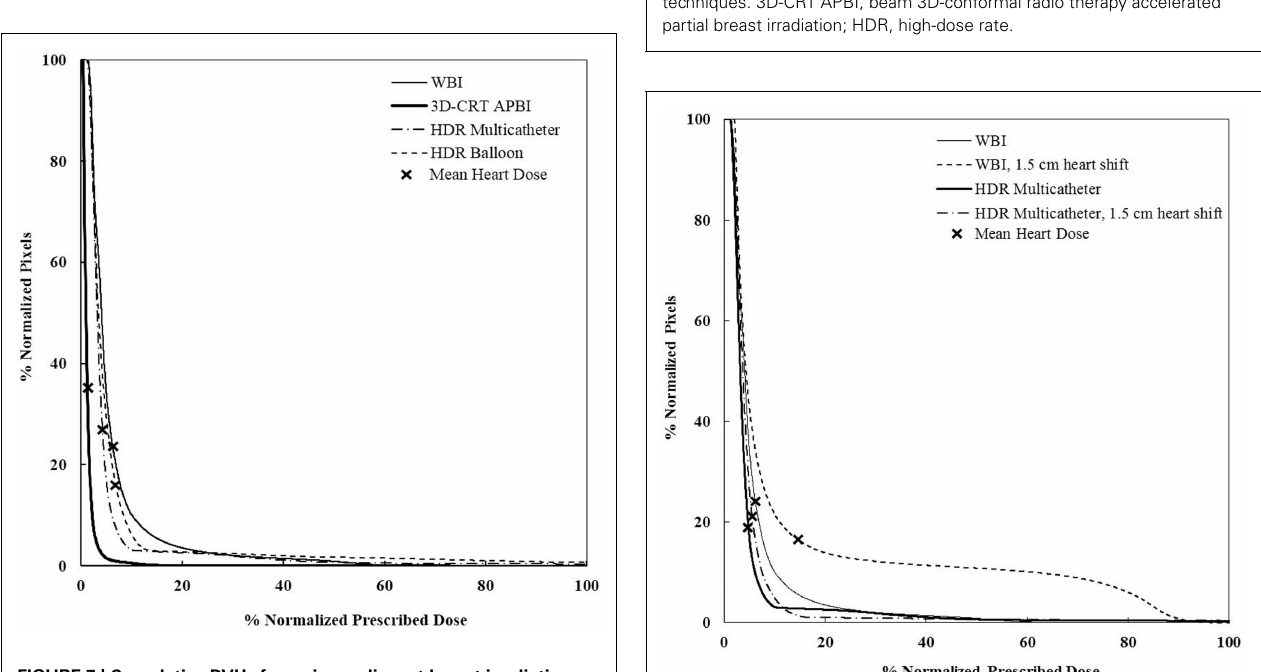
FIGURE 7 | Cumulative DVHs for various adjuvant breast irradiation techniques for a medially located tumor and a medium breast .The 3D-CRT APBI appears to be the safest by far.WBI, whole breast irradiation; 3D-CRT APBI, beam 3D-conformal radio therapy accelerated partial breast irradiation; HDR, high-dose rate.